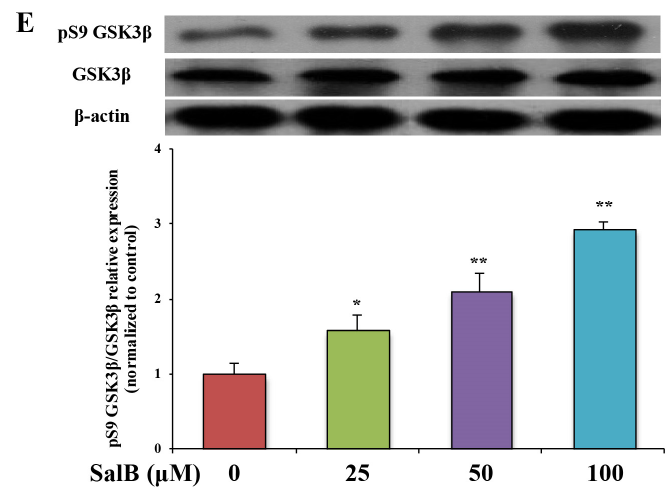
Figure 6. Effect of SalB on oxidative stress and the GSK3 β pathway in SH ‐ SY5Y ‐ APPsw cells. ROS level ( A ); MDA level ( B ); SOD ( C ) and GSH ‐ Px ( D ) activities were measured; pS9 GSK3 β and GSK3 β protein levels ( E ) were determined in SH ‐ SY5Y ‐ APPsw cells. Values are expressed as the mean ± SD in each group ( n = 3). * p < 0.05, ** p < 0.01 vs. control. SalB: Salvianolic acid B.